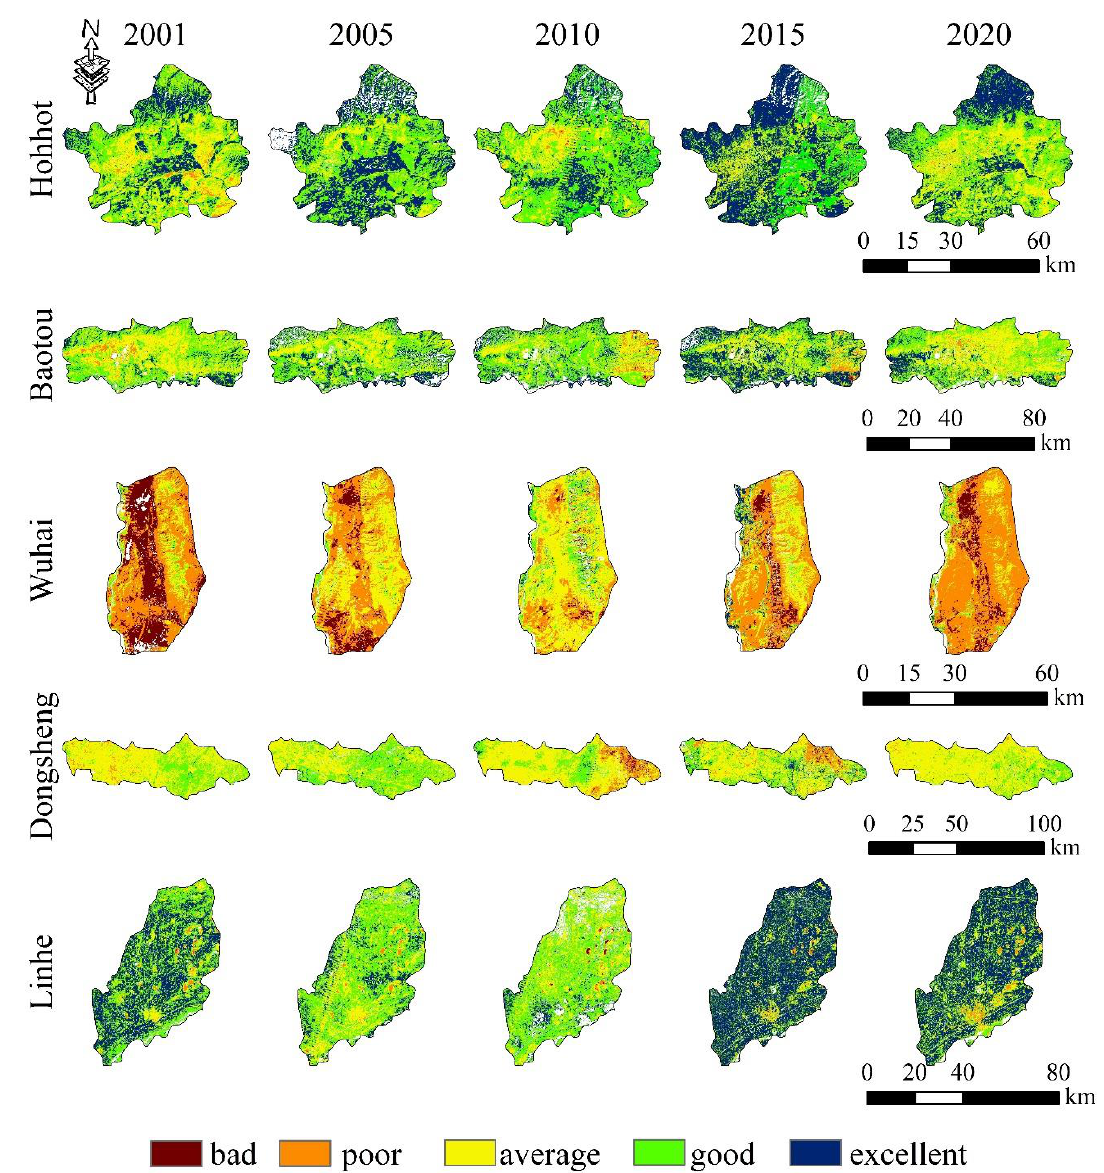
Figure 5. Spatial and temporal distribution of RSEI in the Yellow River Basin, Inner Mongolia, from 2001 to 2020. From top to bottom: Hohhot, Baotou, Wuhai, Dongsheng, and Linhe. Table 1. Average urban RSEI along the Yellow River, Inner Mongolia section.